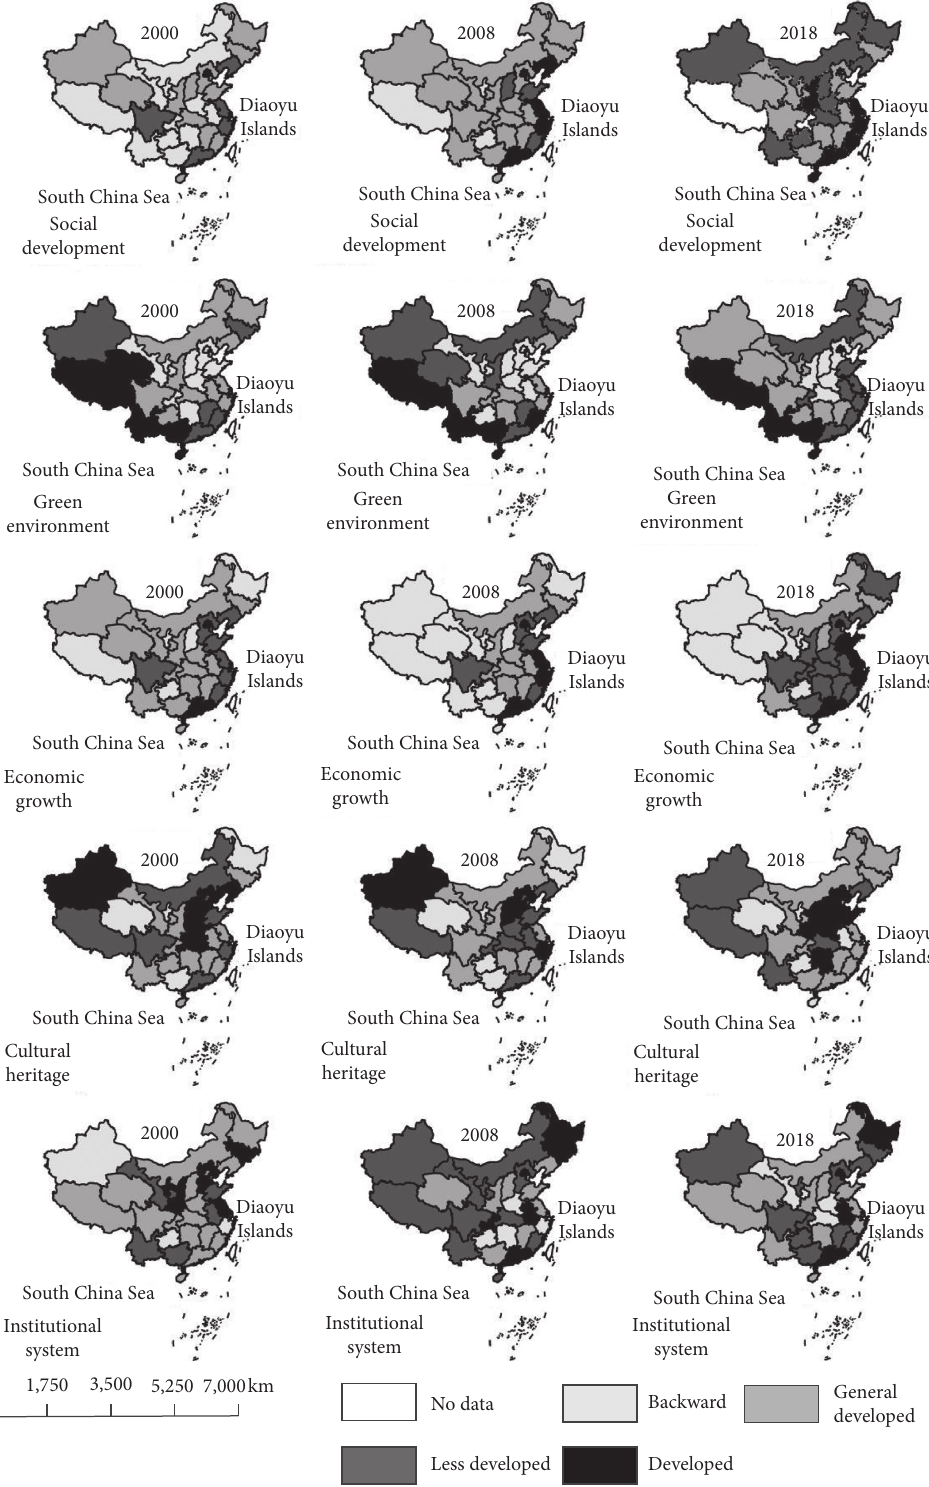
Figure 4: Spatial distribution development of China’s ecological civilization construction (2000, 2008, and